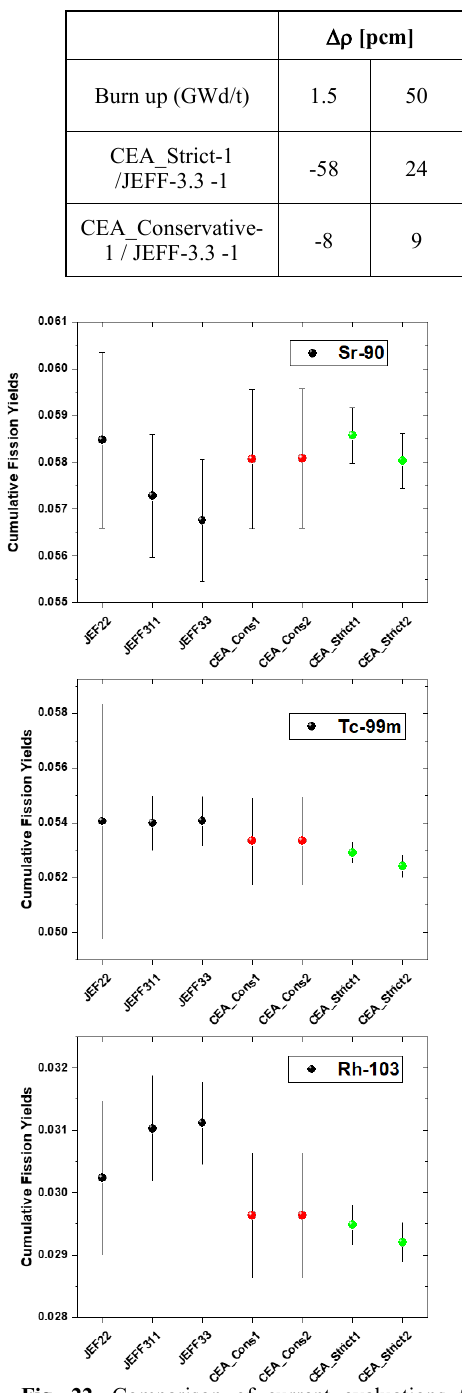
Table 2. Variation of reactivity in reference to JEFF-3.3 calculations.